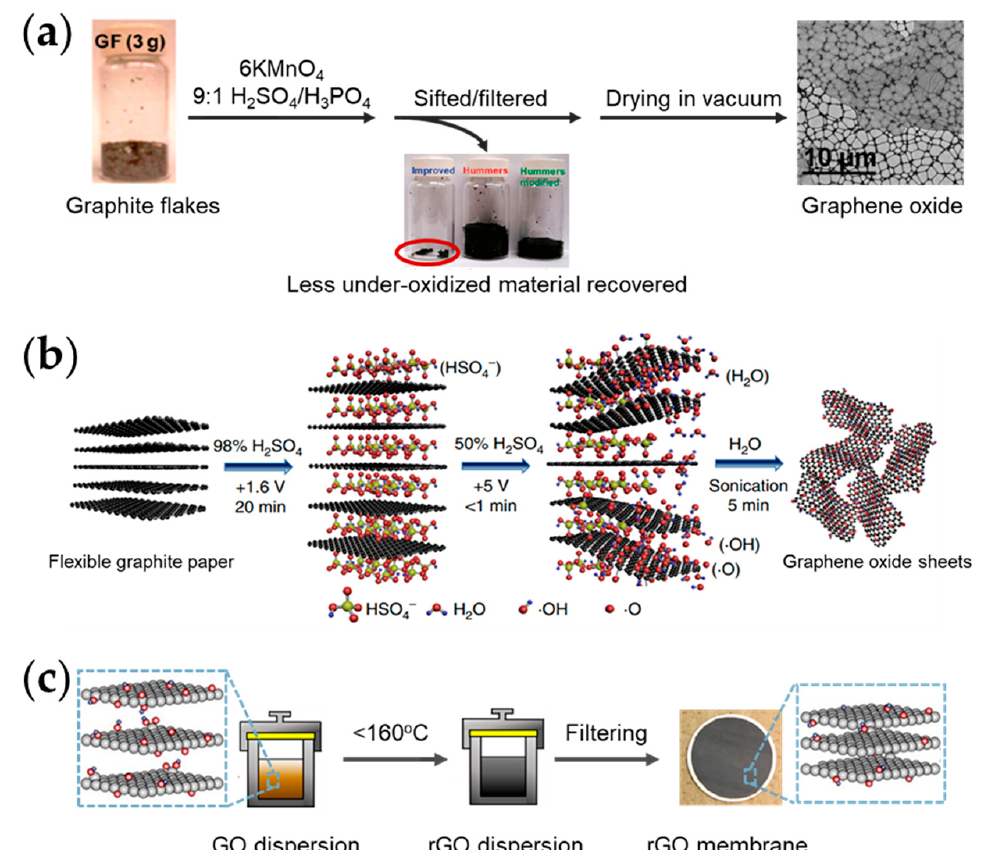
Figure 2. ( a ) Synthesis of graphene oxide by the improved method gives a higher yield of the product than the traditional method [37]. ( b ) GO synthesis by two sequential electrochemical processes with ultrafast reaction times [39]. ( c ) Synthesis of a homogeneous reduced GO membrane by hydrothermal method [47].